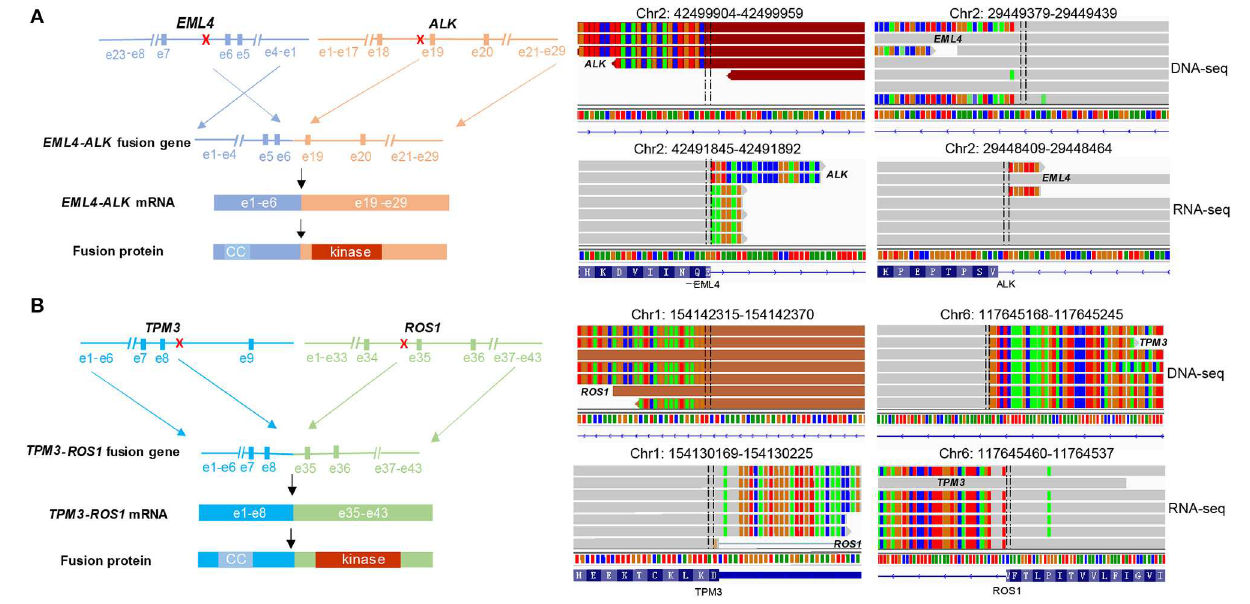
FIGURE 2 | Concomitant EML4-ALK fusion or TPM3-ROS1 fusion were found in each ADC. (A,B) Showed the fusion breakpoints detected by targeted NGS and alterations in gene, mRNA and protein level caused by two fusions, respectively. NGS sequencing reads indicating fusion regions were demonstrated by Integrative Genomics Viewer (IGV) software. CC, coiled-coil domain.